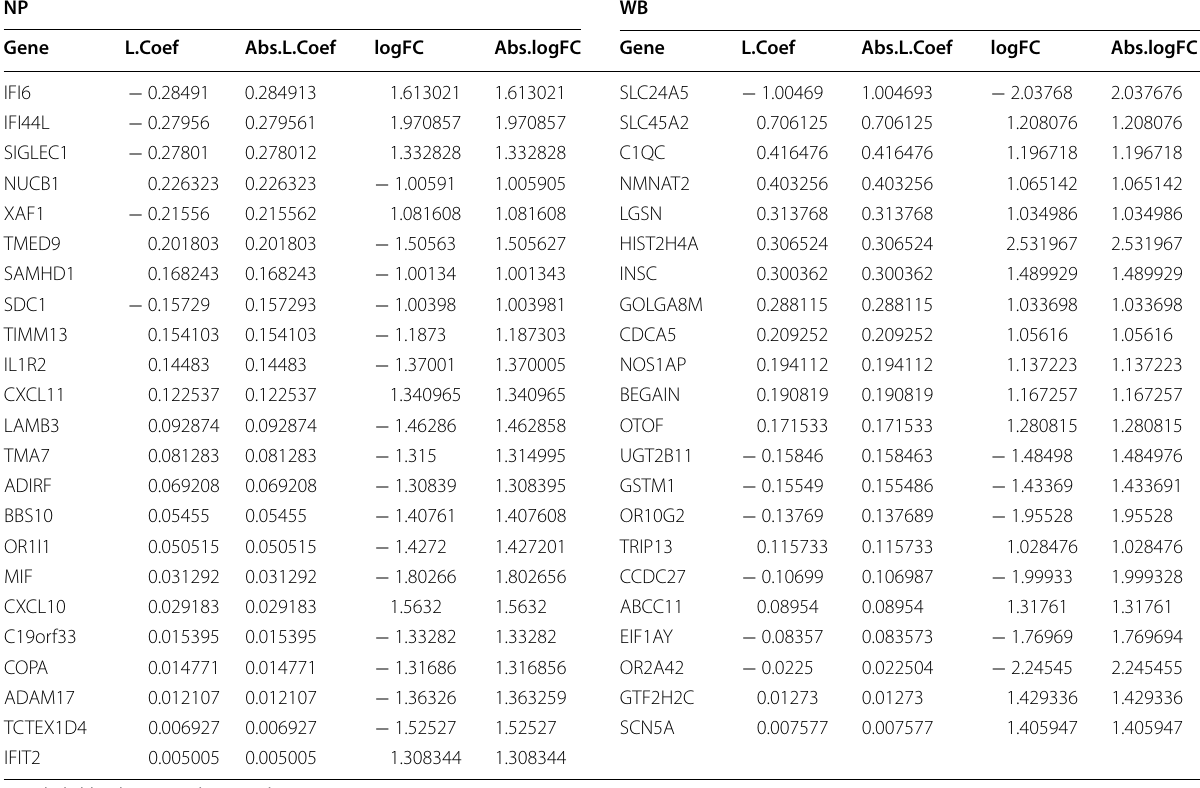
Table 2 The selected features based on the criteria* in the train sets of WB and NP